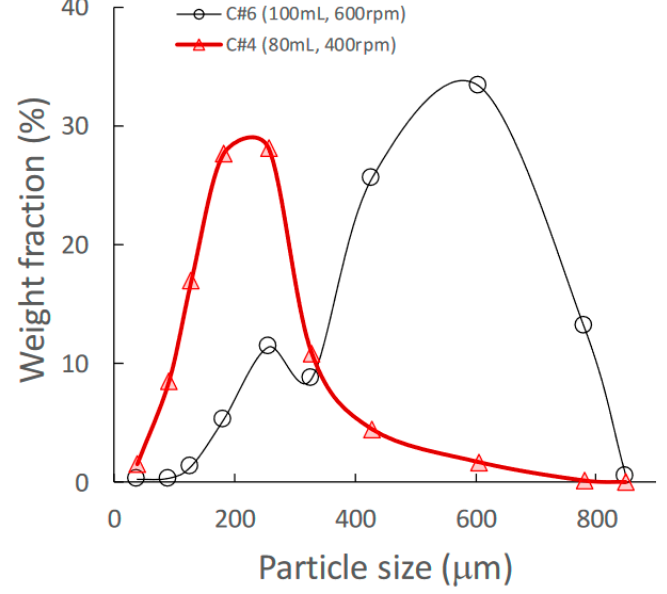
Figure 1. Effect of change in amount of water added on the granular size distribution of high-shear wet granules.